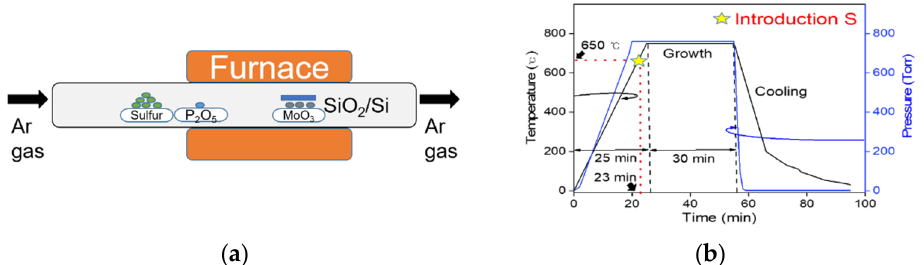
Figure 1. ( a ) Schematic diagram of the chemical vapor deposition (CVD) process for the monolayer MoS 2 synthesis and in situ P doping with P 2 O 5 powder. ( b ) Temperature profile of the reaction furnace and pressure in the quartz tube as a function of the processing time.